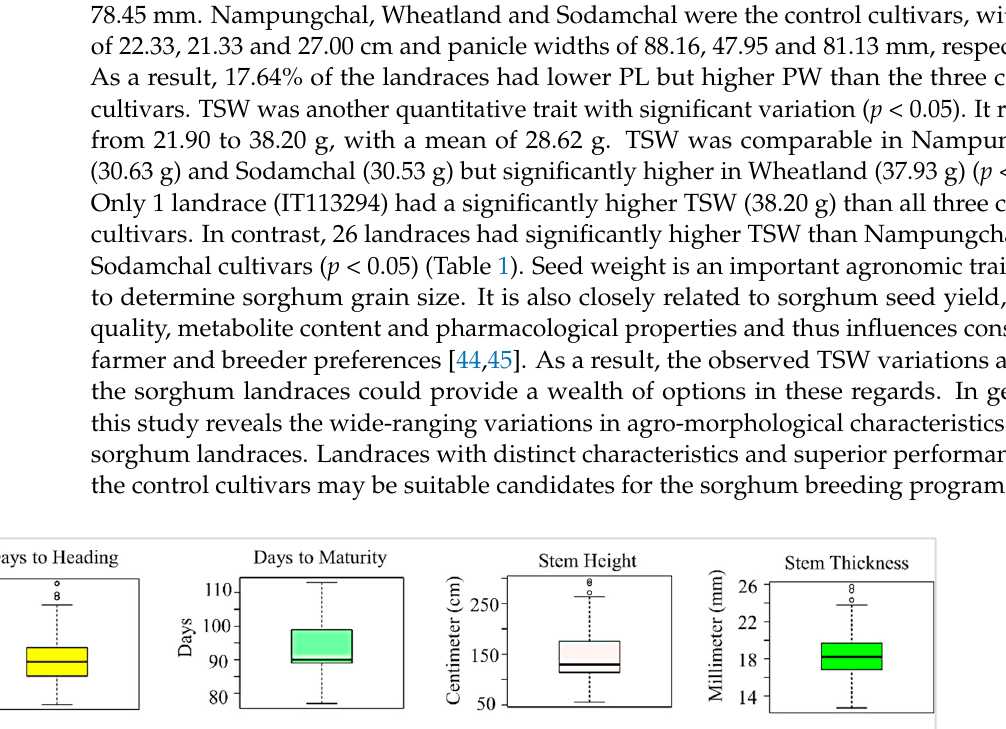
Table 2. Total metabolite contents and antioxidant activities of sorghum genotypes.